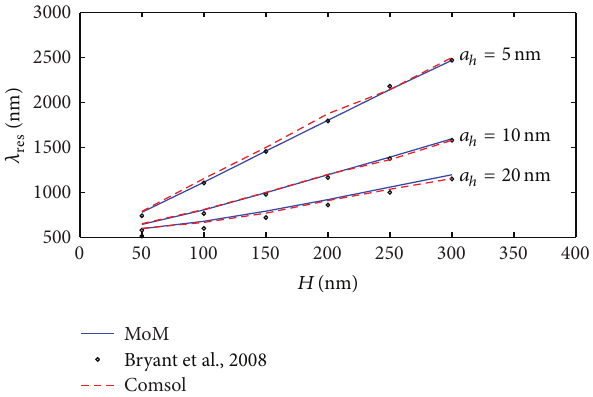
Figure 5: Resonant wavelength of 𝜆/2 mode versus length 𝐻 for different values of radius 𝑎 ℎ .